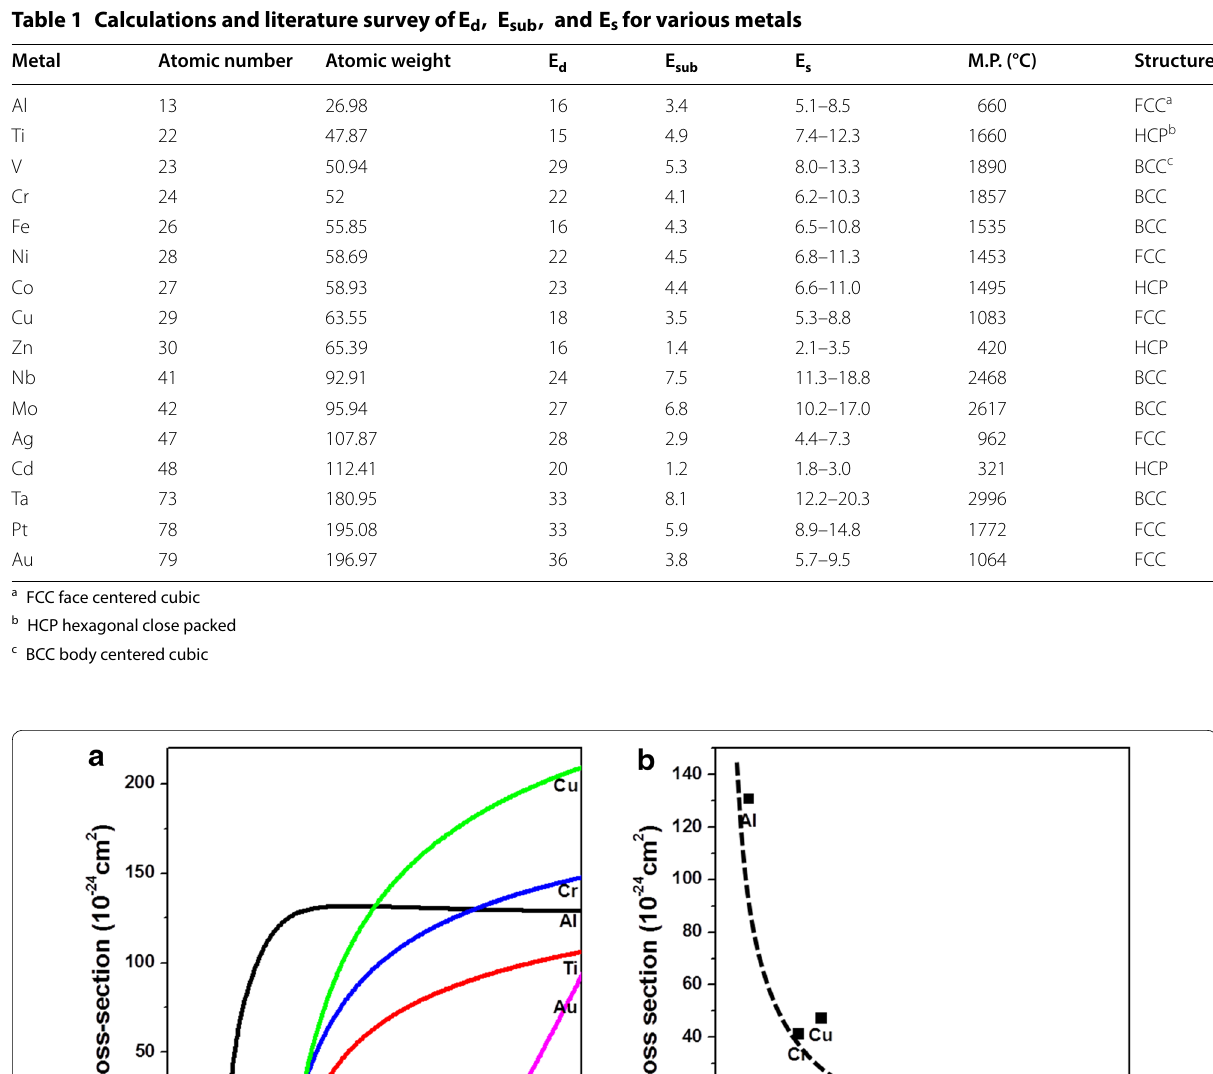
200 kV for Al, Ti, Cr, Cu, and =